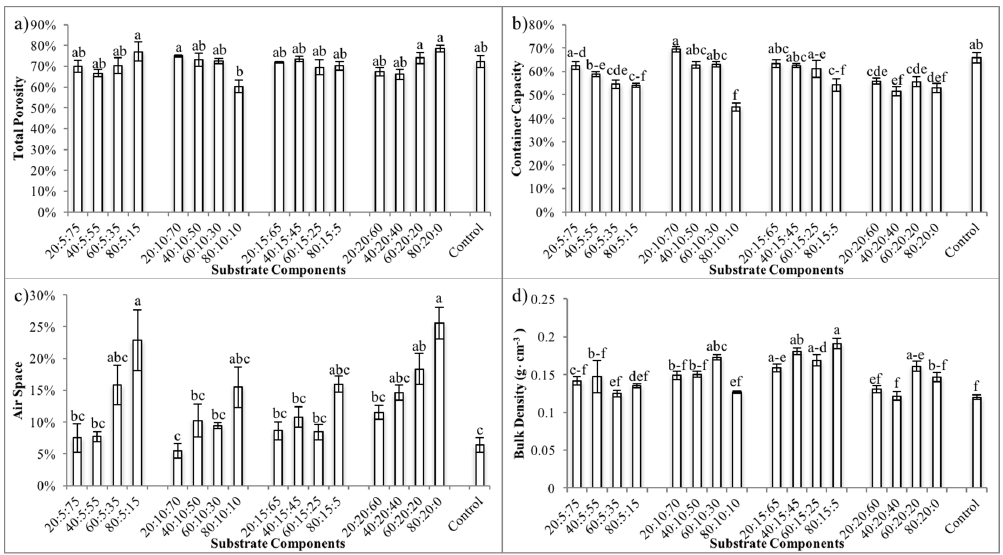
Figure 3. Total porosity ( a ), container capacity ( b ), air space ( c ), and bulk density ( d ) (mean ± standard error) of the 17 di ff erent formulated substrates. The ratios on the X -axis indicate the percentage ratio of biochar to vermicompost to commercial substrate (by volume). The control was 100% commercial substrate (Berger BM7 35BKS). Means indicated by the same letter are not significantly di ff erent according to Tukey’s Honestly Significant Di ff erence (HSD) test at p < 0.05 ( n =